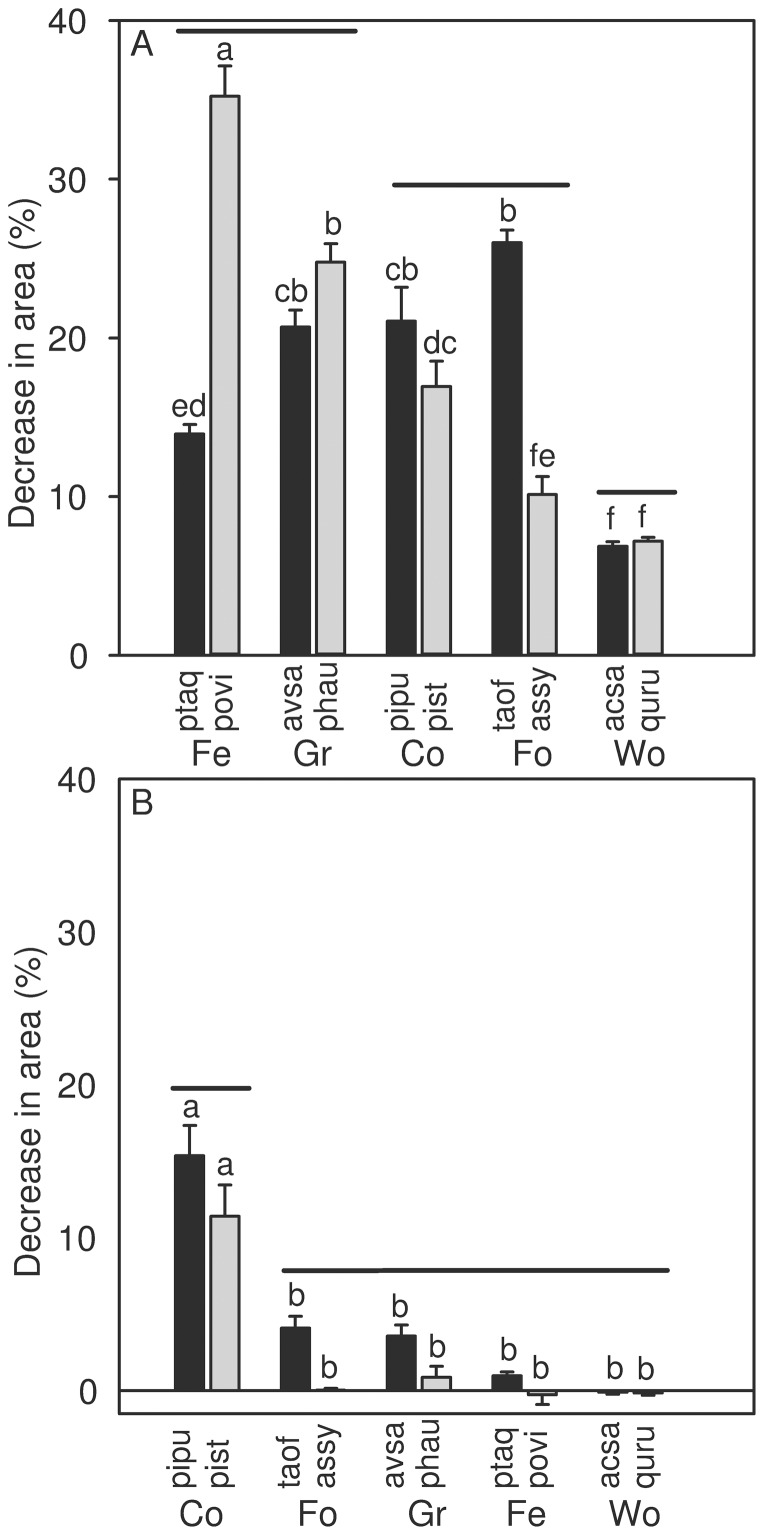
Decrease in area of different growth forms and species after two storage methods.Decrease in leaf area after (A) pressed dry and (B) cold (2°C) storage. Different letters indicate significant differences between species (P≤0.05, n = 250). Growth forms not connected by solid bars are significantly different (P≤0.05). Abbreviations for growth forms are Co - conifer, Fe - fern, Fo - forb, Gr - graminoid, Wo - woody dicot. Abbreviations for species are given in Table 1. Error bars indicate 1 SE.